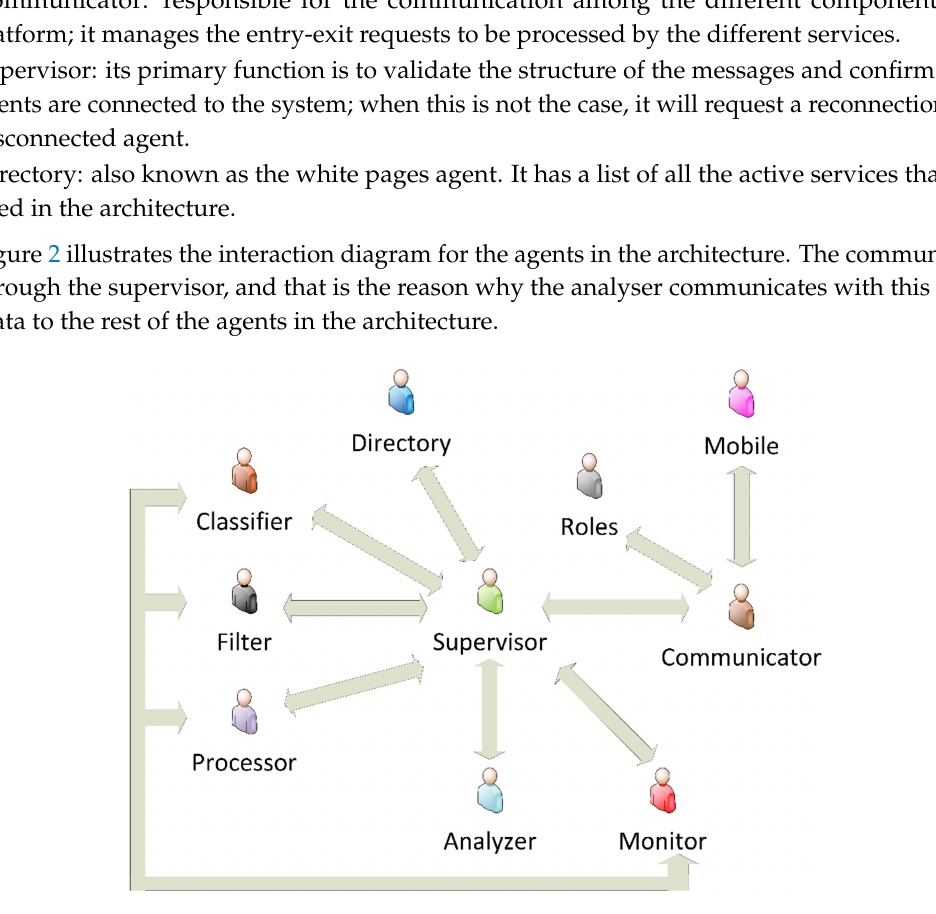
Figure 2. Diagram illustrating the interaction among the roles of an